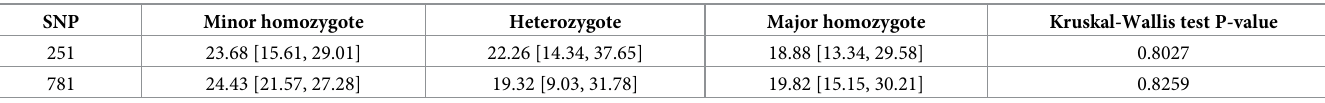
Table 4. Serum IL-8 level according to genotyping of